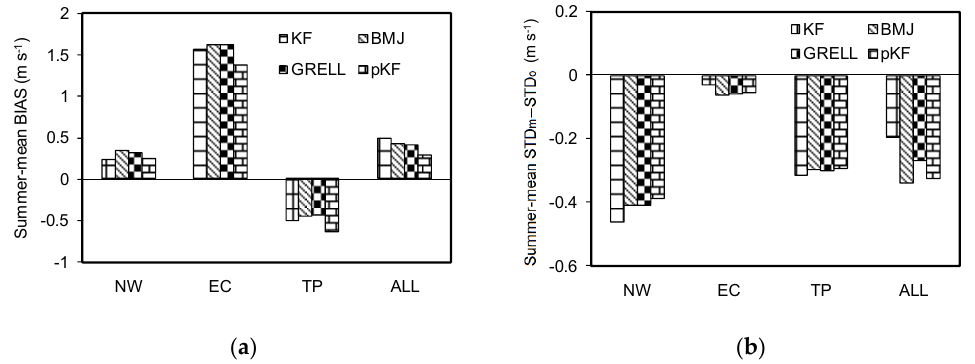
Figure 3. Ensemble seasonal mean wind speed results of BIAS ( a ) and STD M minus the STDo ( b ) for each sub ‐ region, where the regional means of wind speed from reference FNL data for NW, EC, TP, and ALL (land portion of the model domain) are 3.83, 2.42, 4.61, 3.58 m s − 1 , respectively [13]. The FNL data are available at: https://rda.ucar.edu/datasets/ds083.2 (accessed on 24 February 2022).